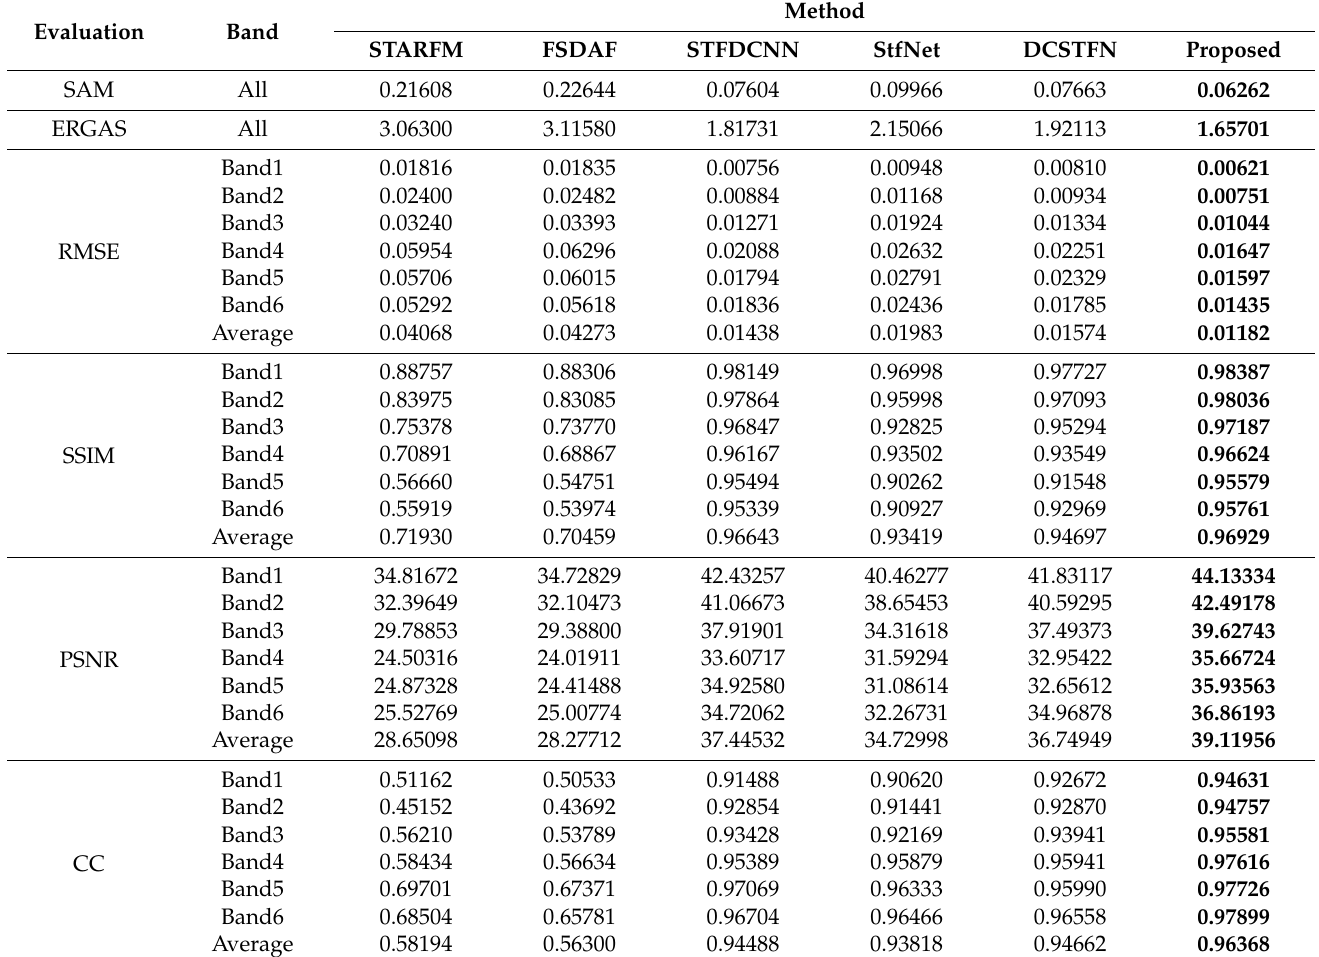
Table 2. Objective metrics of different fusion methods for LGC dataset.